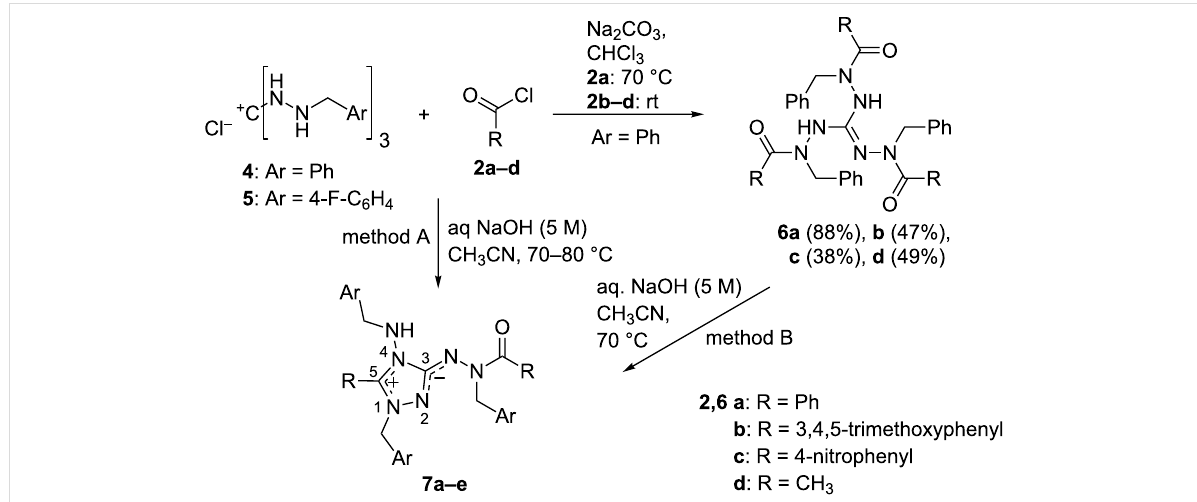
Scheme 3: Reaction of 1,2,3-tris(benzylamino)guanidinium salts 4 and 5 with acyl chlorides to give 1,2,3-tris(acylamino)guanidines 6 and mesoionic 1,2,4-triazolium-3-aminides 7 . See Table 1 for Ar, R and yields of 7 .